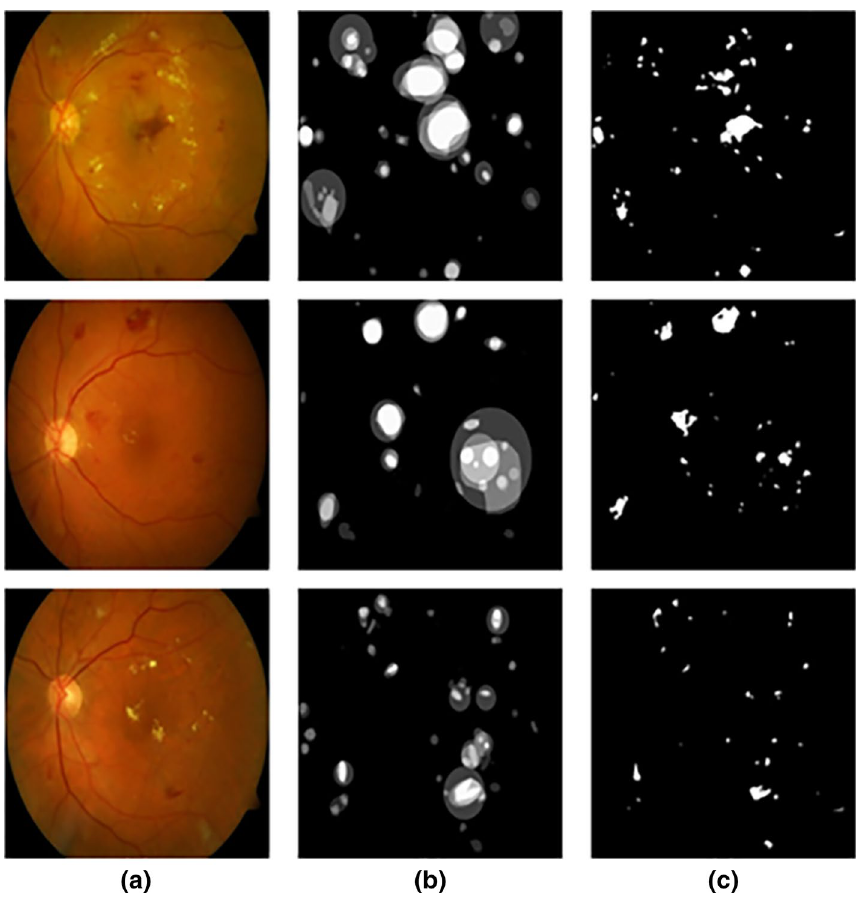
Fig. 15 Results of hemorrhages segmentation a original image, b hemorrhages label and c segmented image